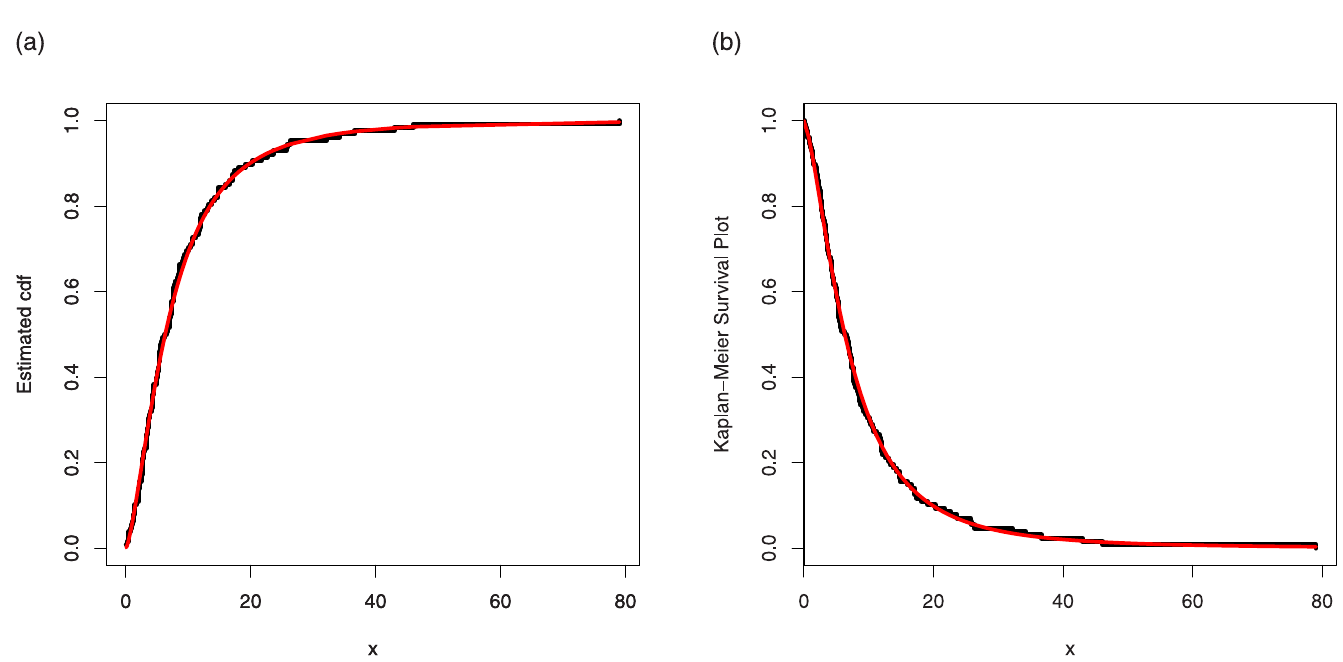
the potentiality of the proposed method, the TI-HTW distribution is applied in comparison with the Ex-APTW, Ku-W and BW distributions. The Ku-W [36]and Ex-APTW [37] have been used to model failure times data. Al-Malki [38] showed that the BW distribution is one of the most prominent extensions of the Weibull distribution that can be used quite effectively in failure rate time data.